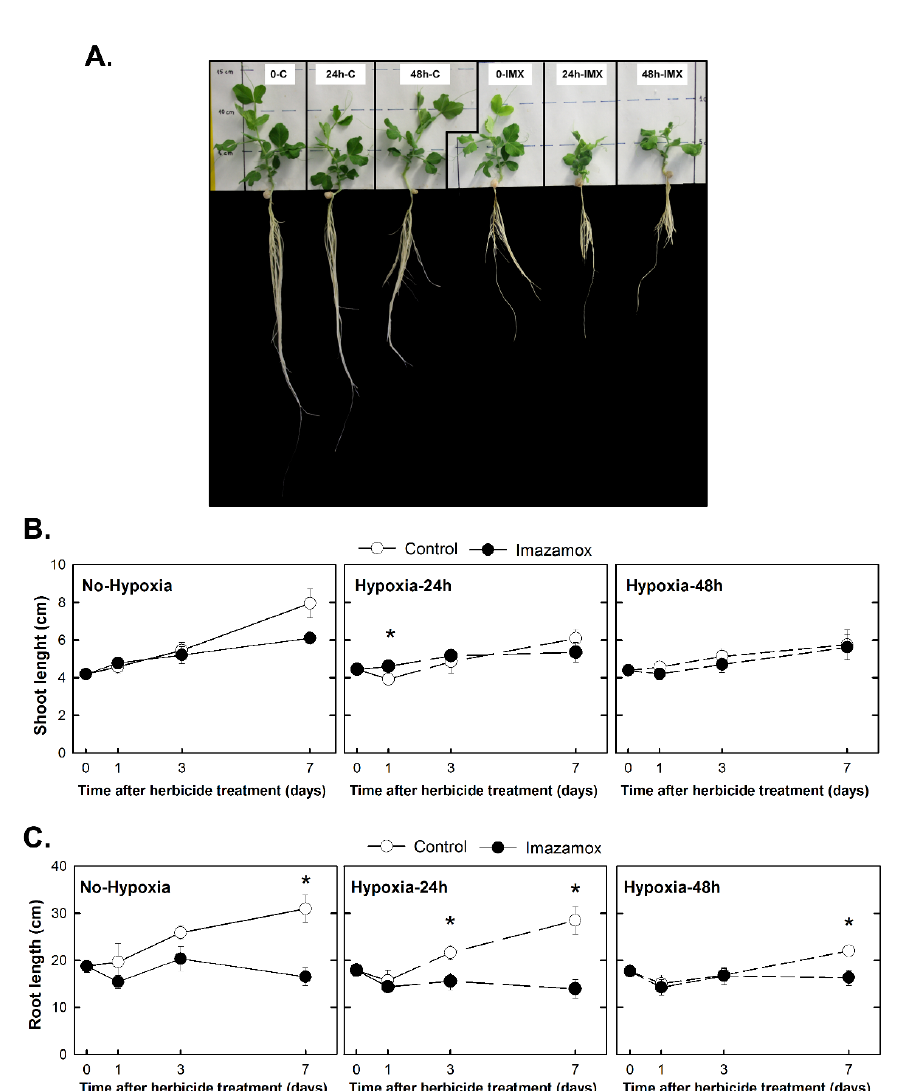
Figure 3. E ff ect of imazamox on the growth of pea plants. Pea plants were not treated with hypoxia before herbicide application (the No-Hypoxia group) or were treated with hypoxia for 24 h or 48 h before herbicide application (the Hypoxia-24h and Hypoxia-48h groups). Half of the plants from each group were treated with imazamox (5 mg L − 1 , black symbols) and the others were not treated with herbicide and were used as controls (white symbols). The di ff erent treatments were named with a combination of two codes: the first code refers to the hours of hypoxia (0, 24 h, or 48 h), and the second one indicates if plants were treated with imazamox (IMX) or they were controls (C): 0-C, 0-IMX, 24h-C, 24h-IMX, 48h-C, 48h-IMX. ( A ) Aspect of the plants 7 days after herbicide application. ( B ) Shoot length ( C ) Root length. Values represent the mean ± SE ( n = 4 biological replicates). Significant variations are marked with * for di ff erences between control and imazamox-treated plants ( t -Test, p < 0.05) on a given day. See Supporting Information Table S1 for the two-way ANOVA results .